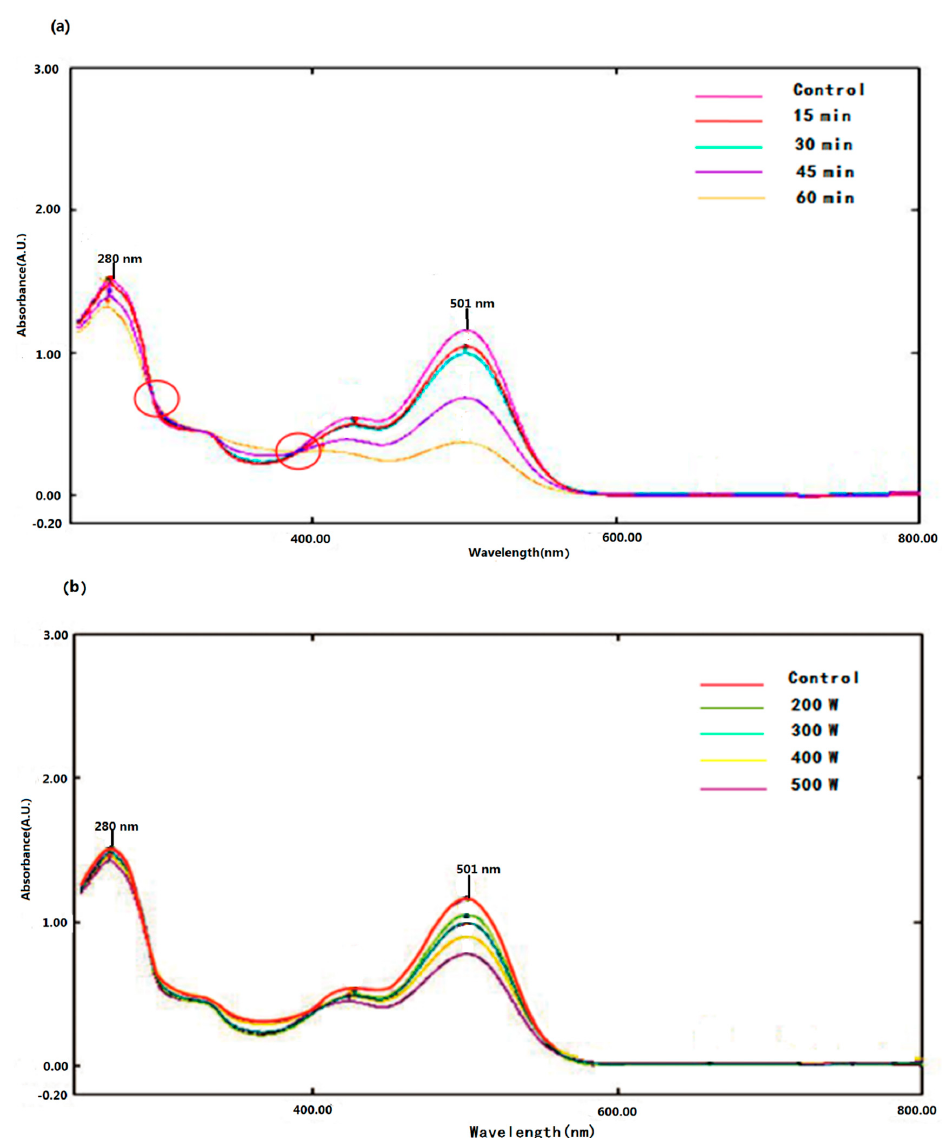
Figure 1. Effect of ultrasonic power and treatment time on the spectra of Pg-3-glu. ( a ) Ultrasonic power 300 W, treatment time varied from 15 min to 60 min; ( b ) treatment time 30 min, ultrasonic power varied from 200 W to 500 W.